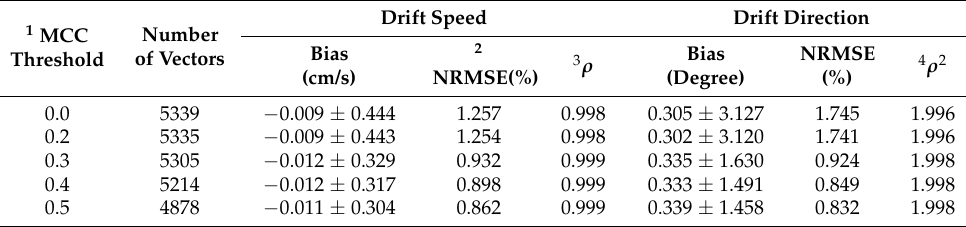
Figure 6. Comparison of the drift vectors derived from COSMO-SkyMed and SVP buoys. ( a ) Scatter plot of the drift speed. Black line is the identity and regression line, and the color represents maximum cross correlation of the pattern matching result. ( b ) Histogram of the difference in drift direction. The y -axis is in log scale. Table 3. Accuracy evaluation results of the COSMO-SkyMed-derived sea ice drift vectors.